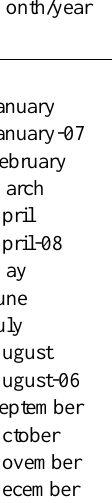
Table 2. Primary production in the upper 40m of the water column in central-southern Chile according to Daneri et al. (2000), and mea- surements carried out during this study in January 2007, April 2008, and August